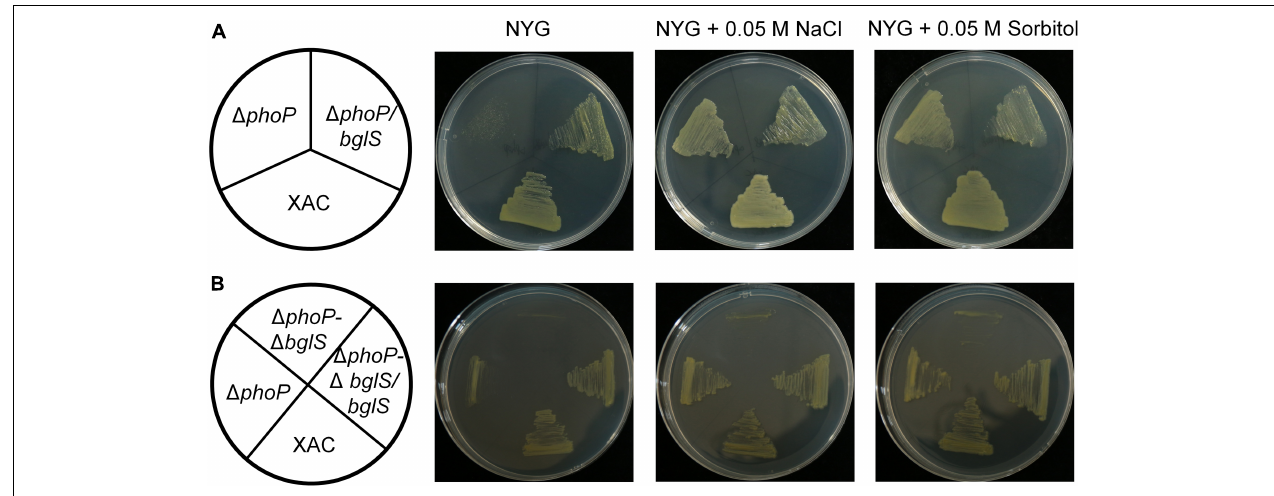
FIGURE 4 | Critical role of BglS in reversing the growth disadvantage of phoP mutant under low osmostress. (A,B) Growth of bacterial strains on rich NYG medium plates or NYG medium plates supplemented with 0.05 M NaCl or 0.05 M sorbitol.